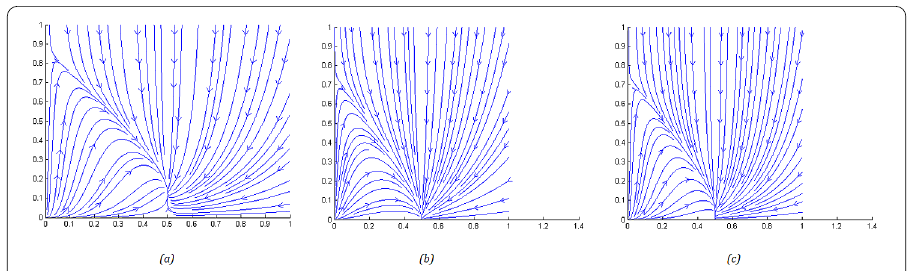
Figure 1 The phase portrait of system